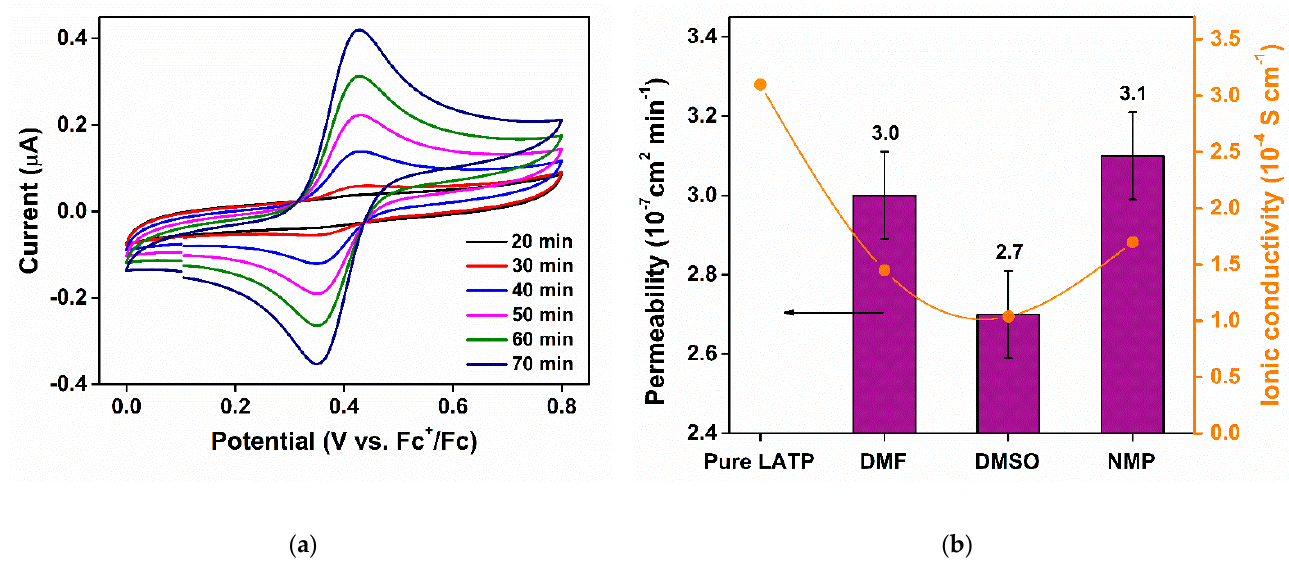
Figure 7 . ( a ) Example of time dependent CV trends used for calculation of membrane’s permeability coefficient; ( b ) permeability − IC correlation for LATP+PVDF fabricated using different solvents. Electrolyte composition: 0.5 M TEMPO + 1.0 M LiClO 4 in PC .